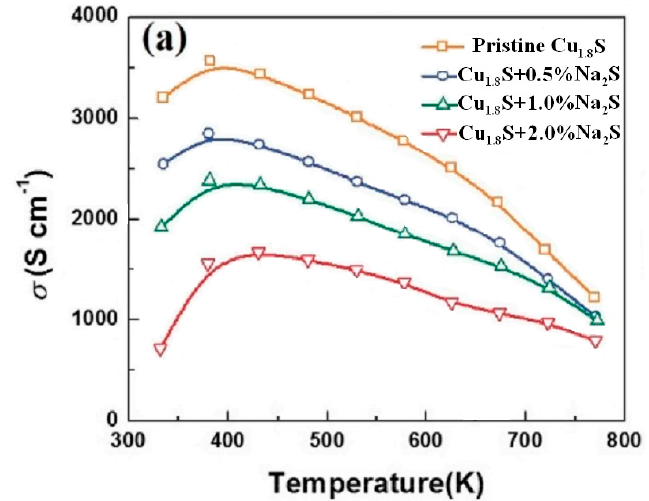
Figure 3. Temperature dependence of electrical conductivity of bulk Cu 1.8 S samples doped with Na 2 S ( x = 0, 0.5, 1, 2 wt.%). Reprinted with permission from ref. [138]. Copyright 2020 Elsevier.